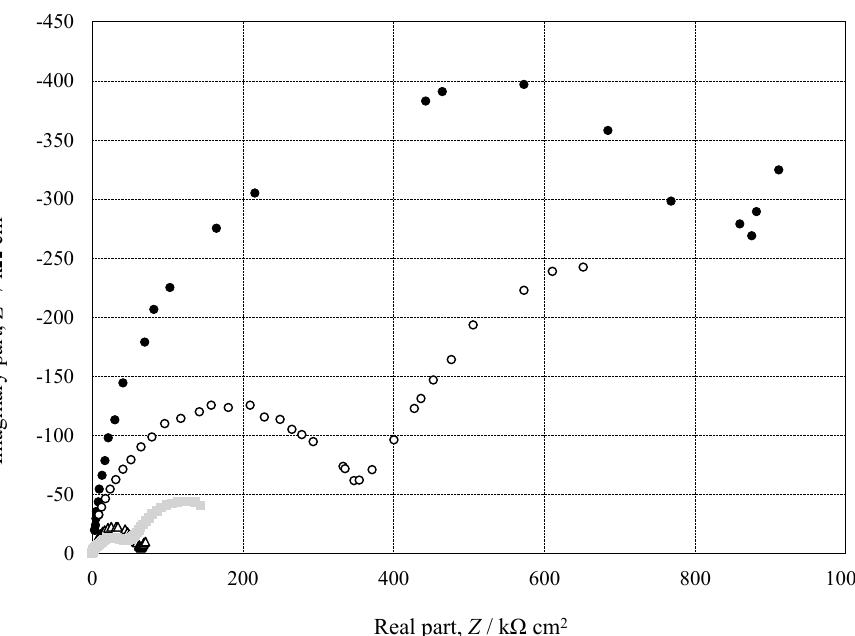
Figure 12. Nyquist plot on pure Al ( ● ), 1050- ( ○ ), 3003- ( △ ) and 5052- ( □ ) Al alloys with t a = 3600 s and t s = 1200 s, obtained by EIS measurements. EIS measurements were carried out in 2.0 kmol m − 3 -NaCl solution after bubbling N 2 gas for 1200 s.